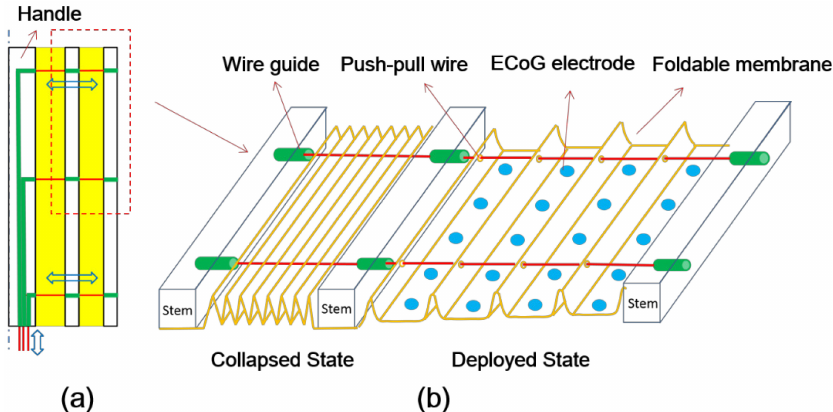
Figure 1. ( a ) Conceptual design of the deployable planar device. The foldable membranes, which may incorporate thin film electrode arrays, are suspended between stems via push-pull wires. These electrode arrays may, for example, be used for electrocorticography (ECoG) monitoring of cortical surfaces. ( b ) Zoomed view of the device in its collapsed and deployed